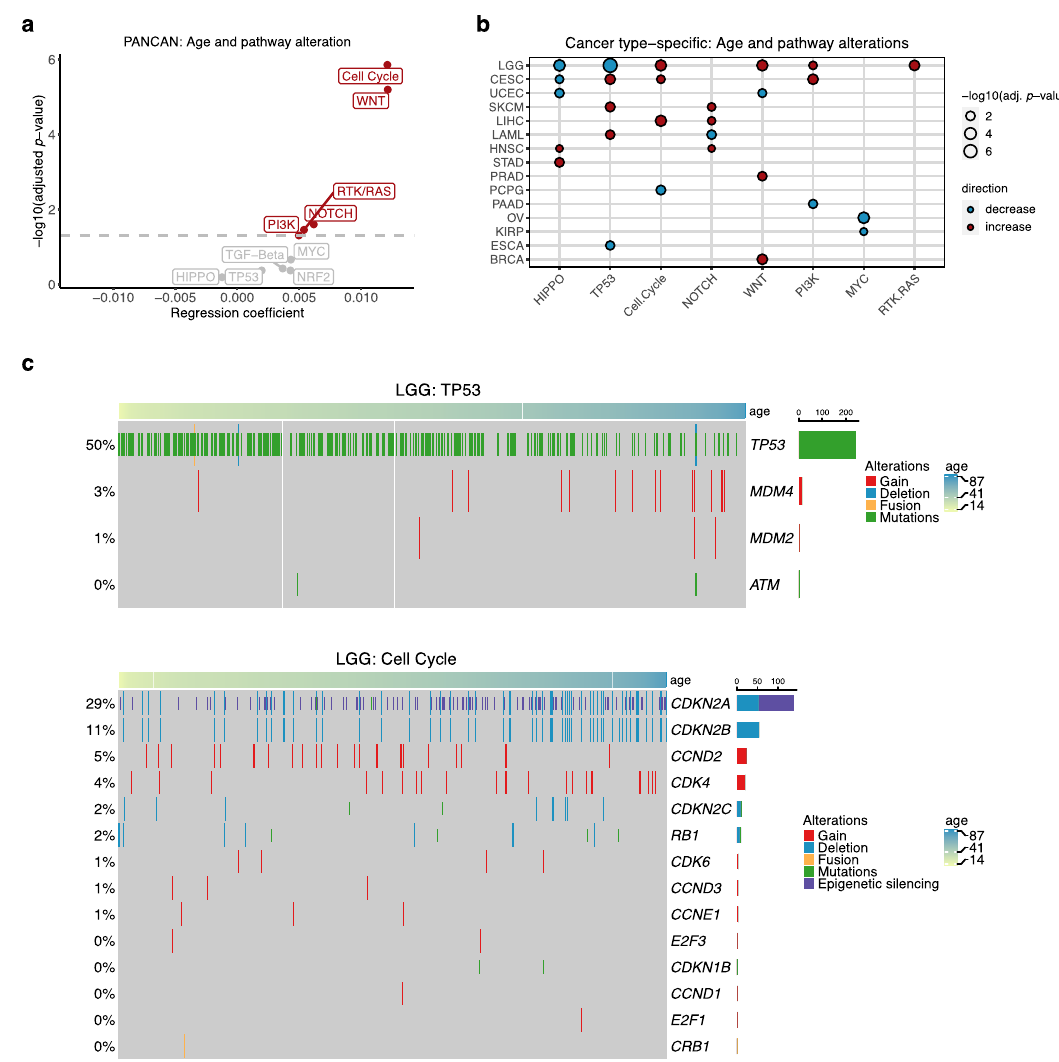
Fig. 5 Association between cancer patients ’ age and oncogenic signalling pathway alterations. a Association between age and oncogenic pathway alterations in the pan-cancer level. Multiple logistic regression coef fi cients and signi fi cant values are shown. Multiple-hypothesis testing correction was done using Benjamini – Hochberg procedure. Pathways with a signi fi cant positive association between age and alterations (adj. p value < 0.05) are highlighted in red. b Cancer-speci fi c age-associated pathway alterations. Pathways that show a signi fi cant positive and negative association with age per cancer type (multiple logistic regression, adj. p value < 0.05) are displayed in red and blue dots, respectively. Multiple-hypothesis testing correction was done using Benjamini – Hochberg procedure. c Heatmap showing age-associated alterations in genes associated with TP53 and cell cycle pathways in LGG. Samples are sorted by age. Colours represent types of alteration. TCGA cancer type acronyms and their associated name are provided in Table